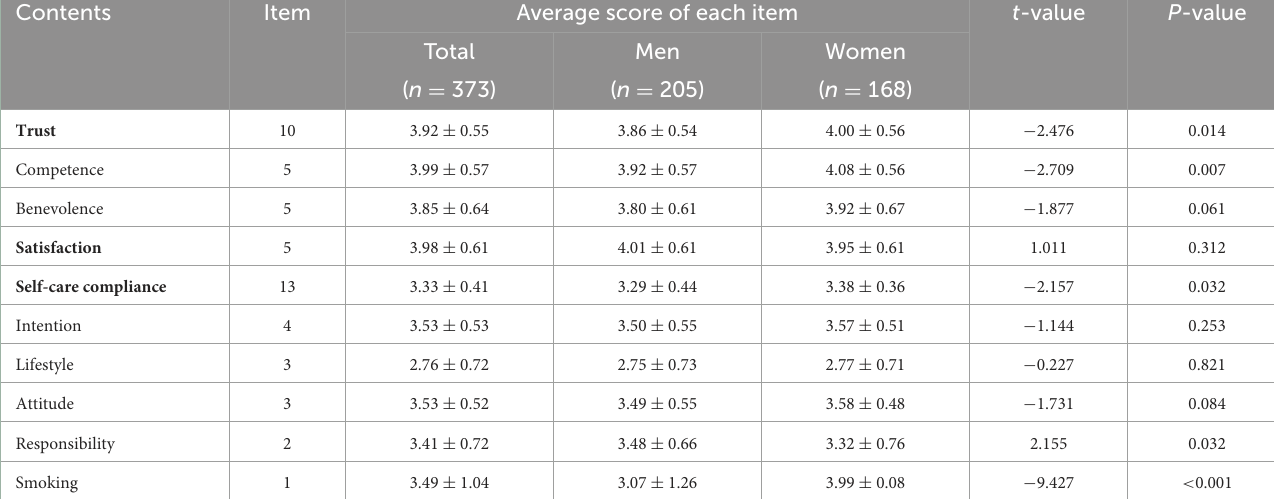
TABLE 2 The description of trust, satisfaction, and self-care compliance scores (mean ± SD).